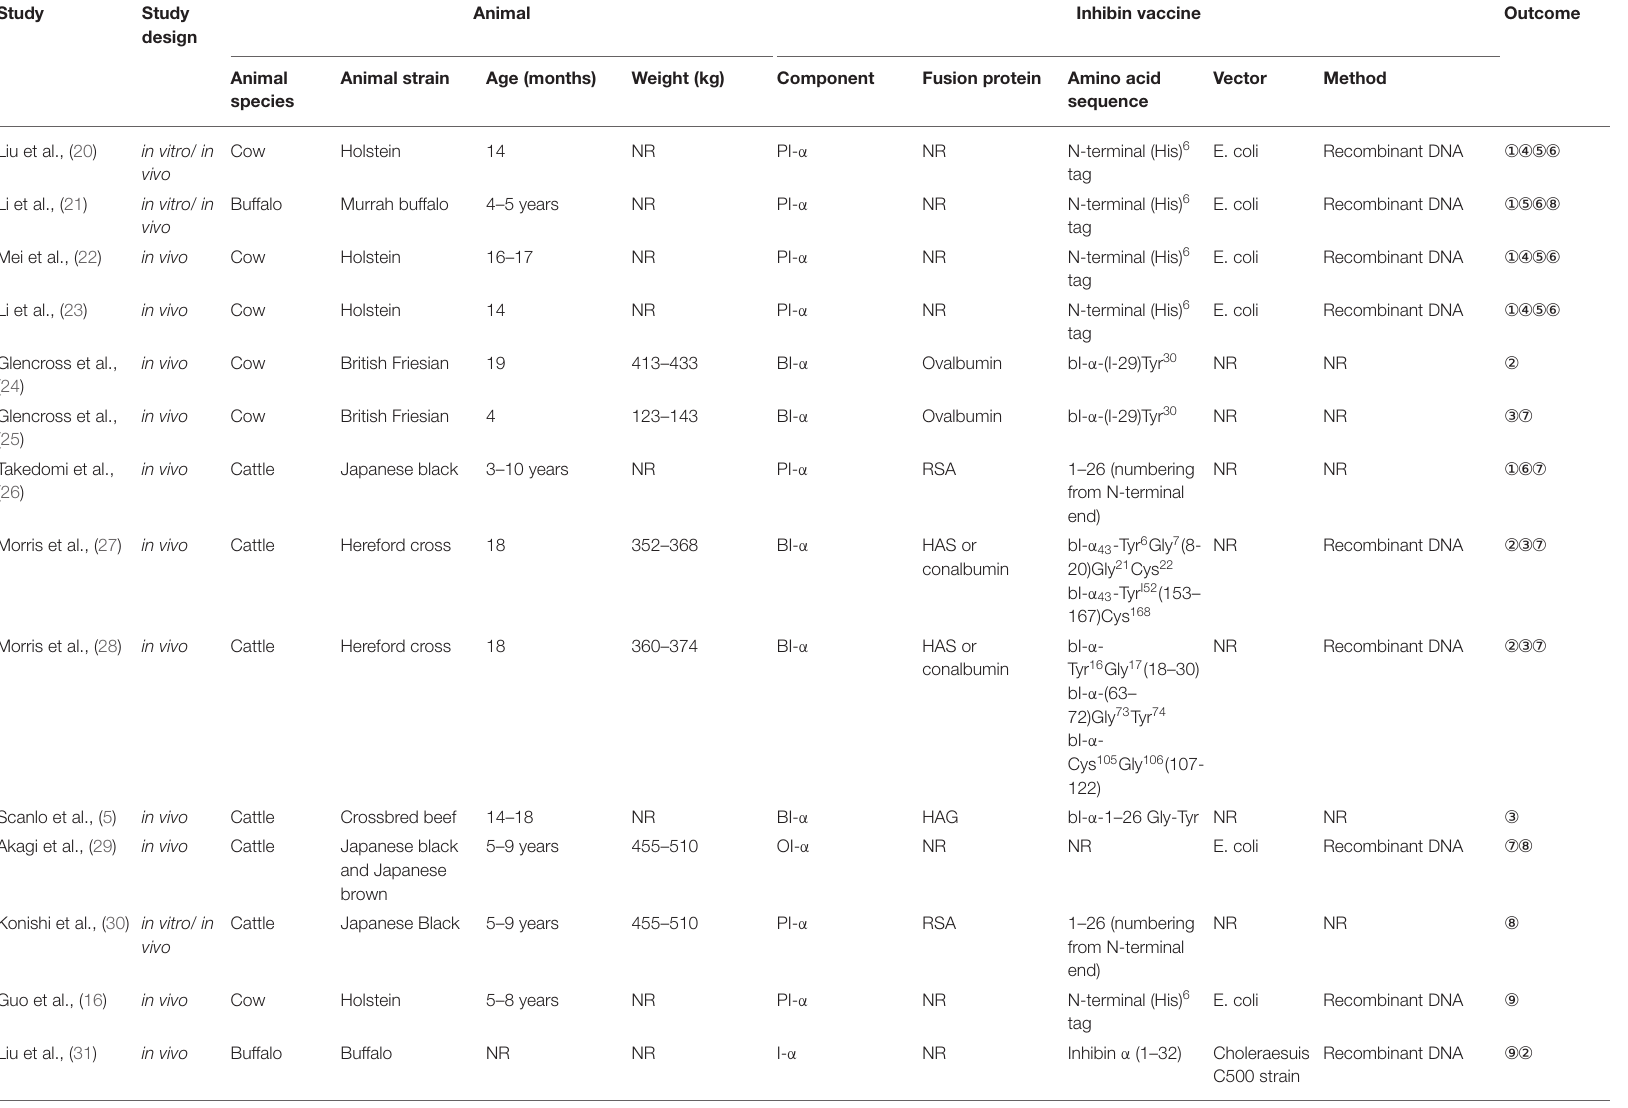
TABLE 1 | Characteristicsof the 12 included